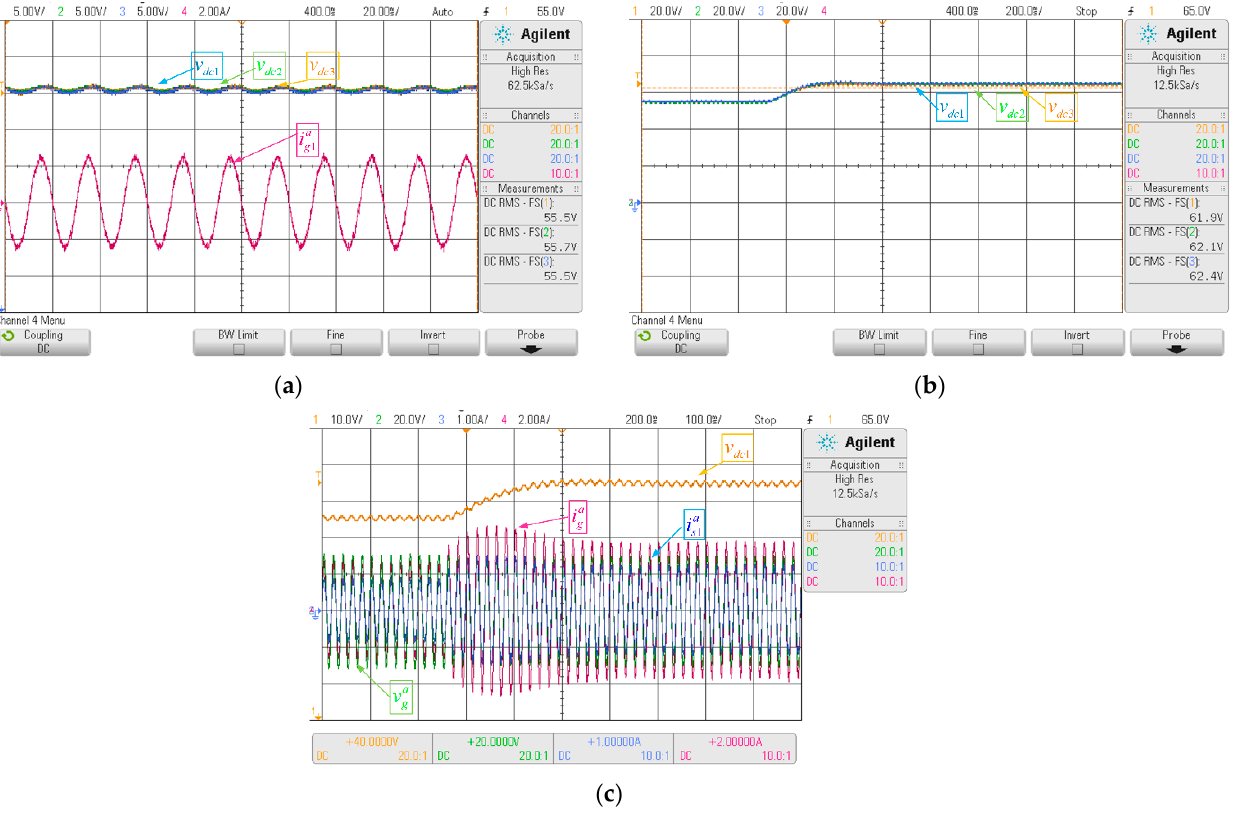
Figure 7. Key waveforms DC voltage control: ( a ) steady-state behavior, ( b ) dynamic behavior with step input in DC voltage reference, ( c ) change reference in input current loop due to change